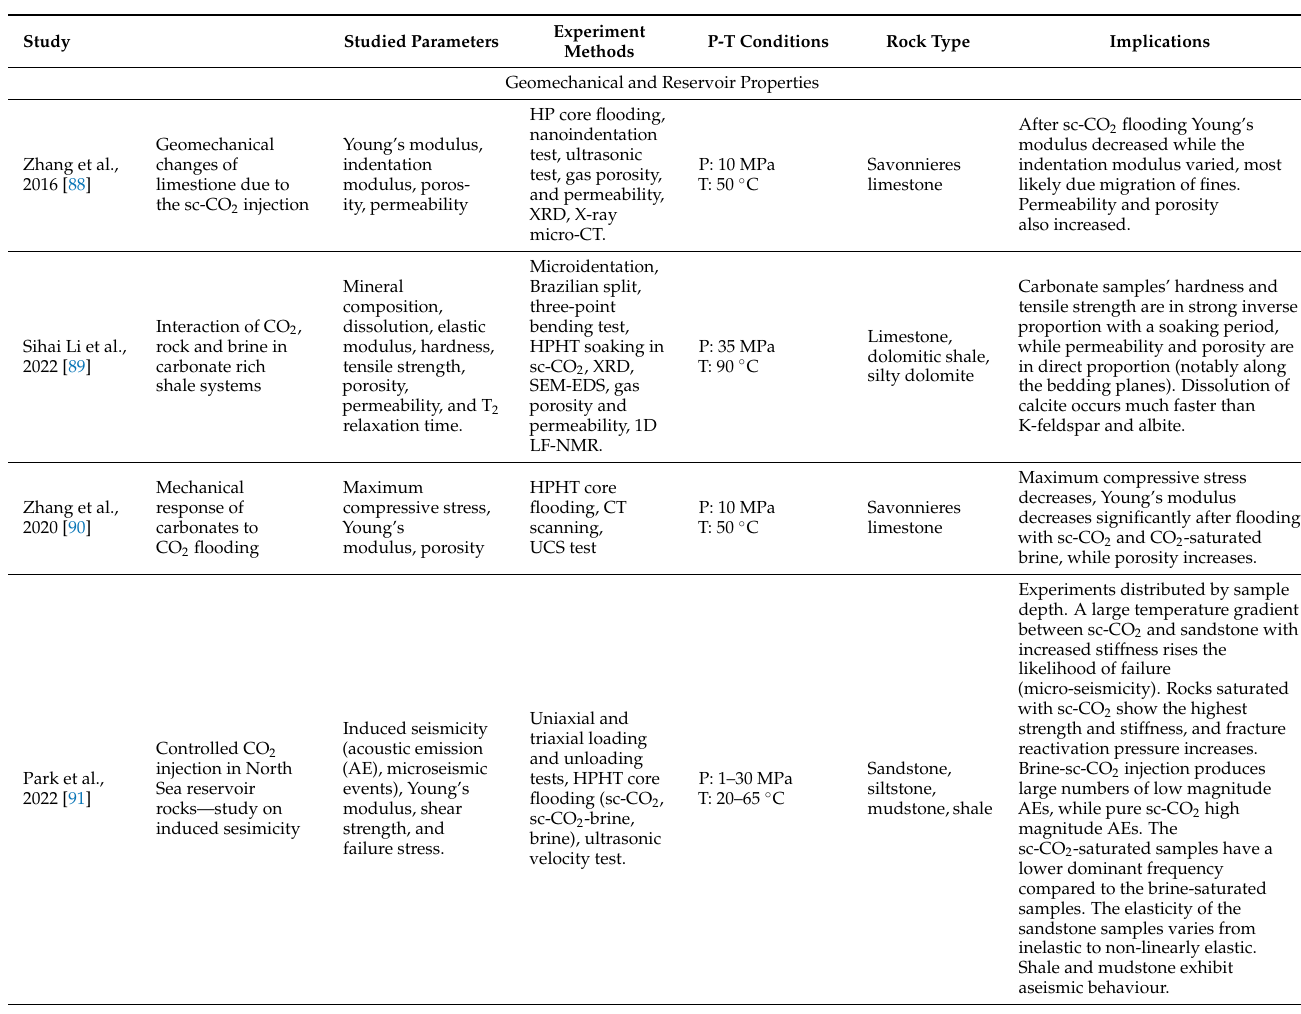
Table 1. Experimental programs for evaluating CO 2 injection impacts on different rock types, catego- rized by application